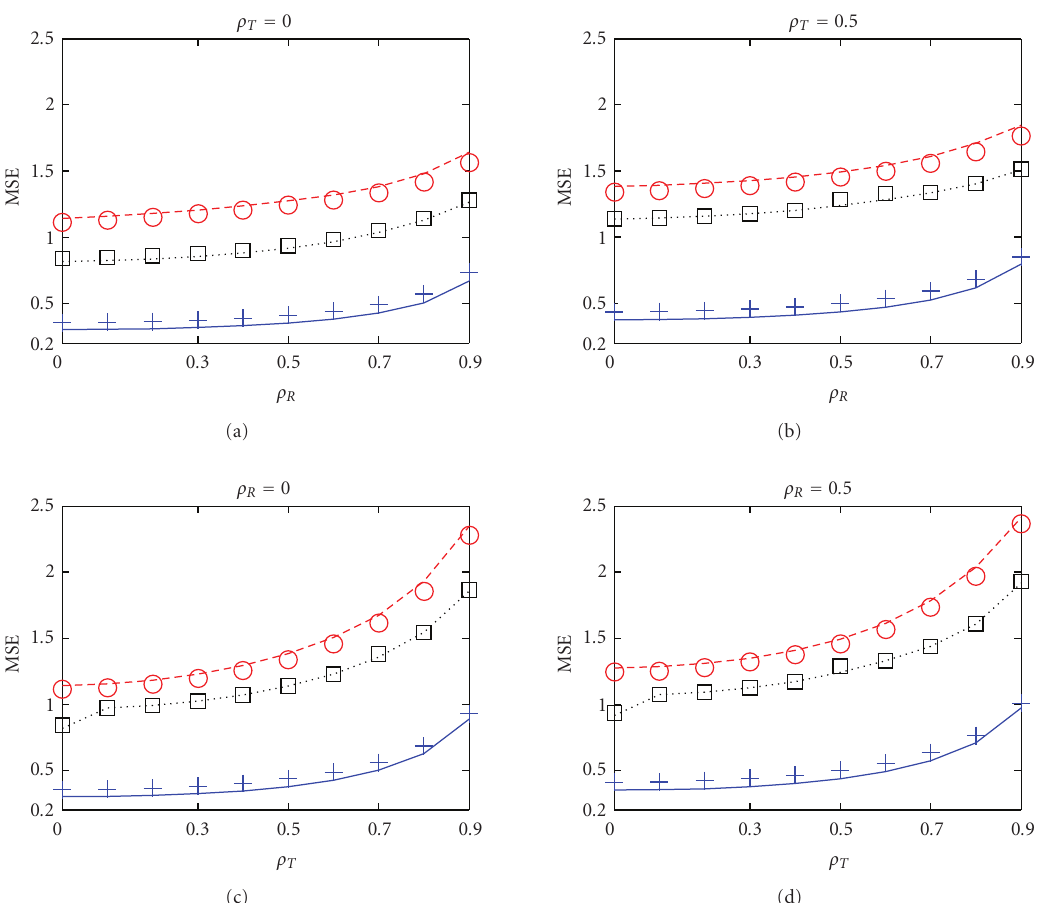
Figure 8: MSE as functions of ρ T (with fixed ρ R ) and functions of ρ R (with fixed ρ T ) under per-antenna and per-cell power constraints. The total transmission power is 16dB. System parameters are shown in example 1 of Table 1. ( Legends are the same as in Figure 5.